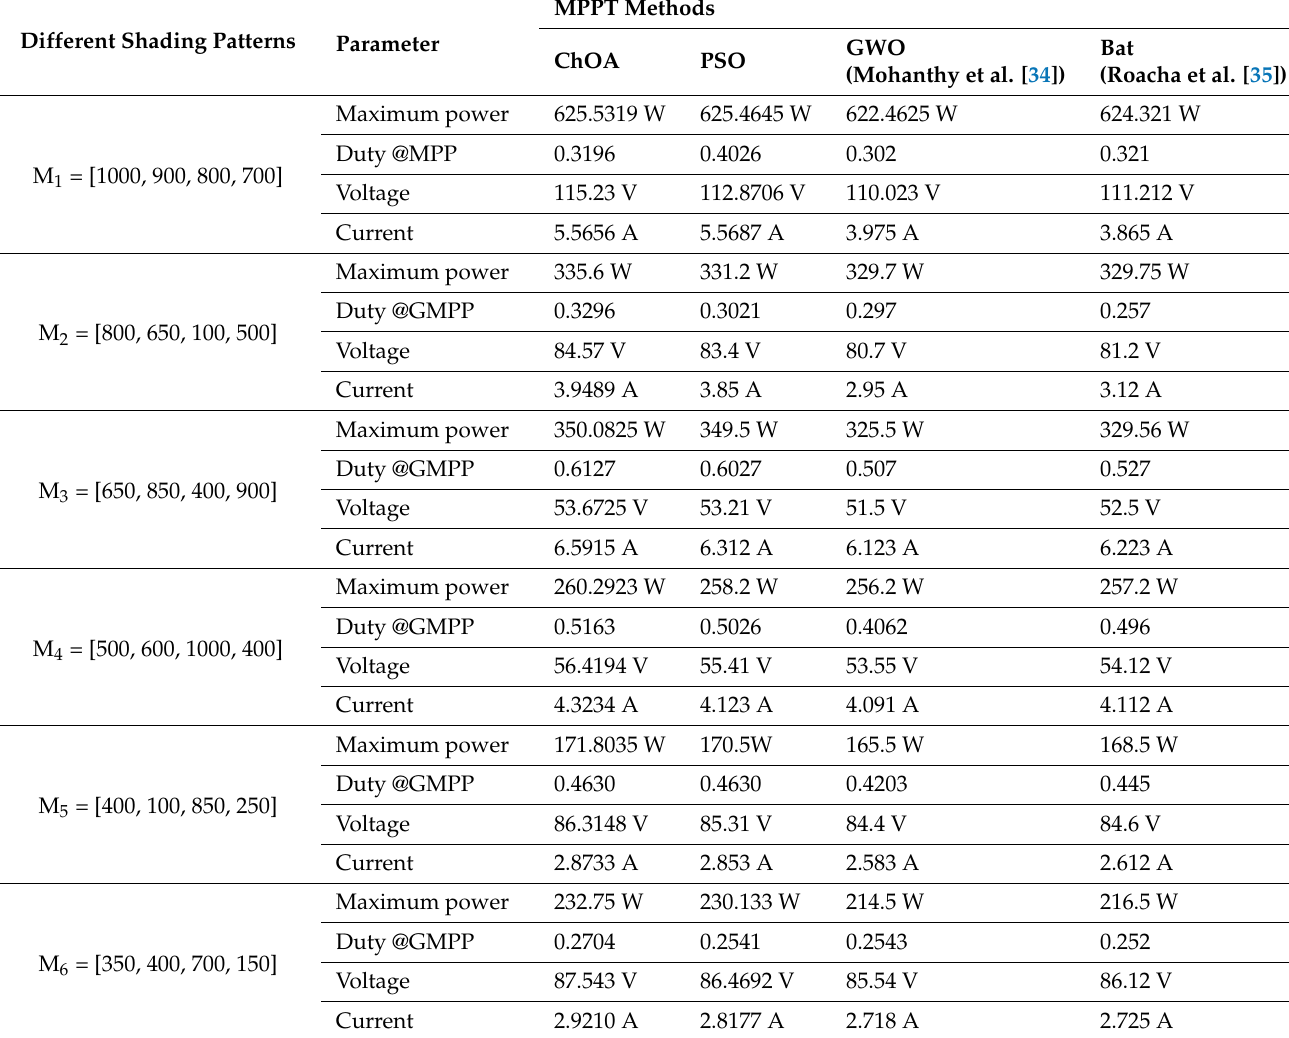
Table 6. Summarization of statistical simulation results like power, voltage, and current of PV module under partial shading